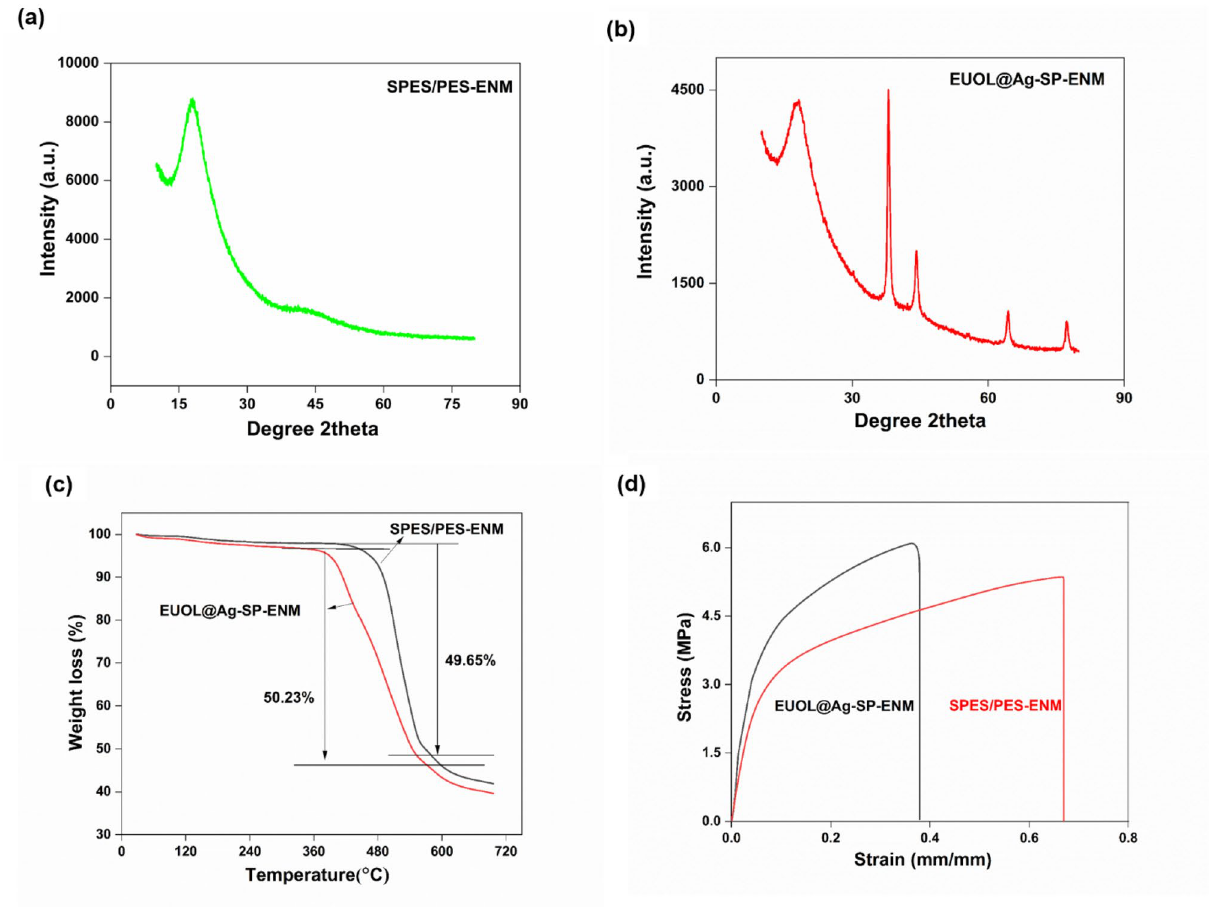
Figure 3. XRD results of ( a ) SP-1 ENMs, and ( b ) SP-5 ENMs ( c ) TGA results of SP-1 and SP-5 ENMs, and ( d ) Tensile strength of SP-1 and SP-5